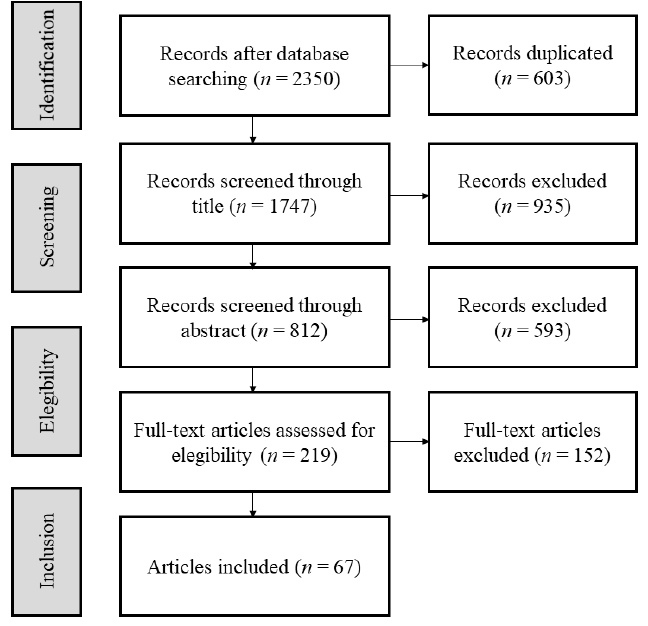
Figure 1. Flowchart of the selection process.